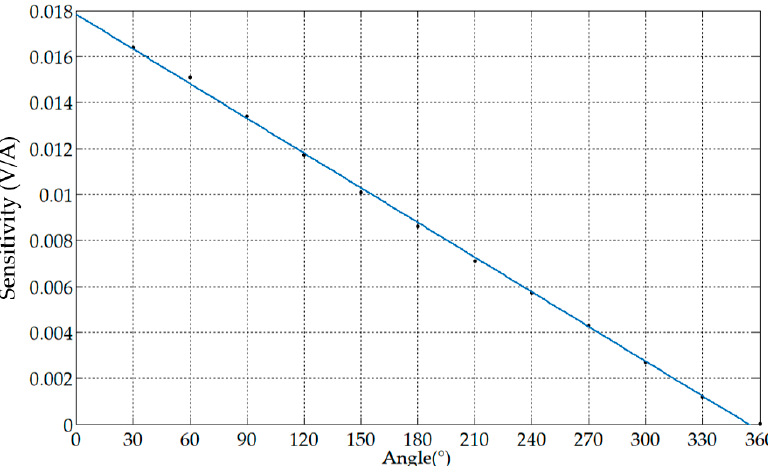
Figure 11. The relationship between distribution angle and sensitivity.